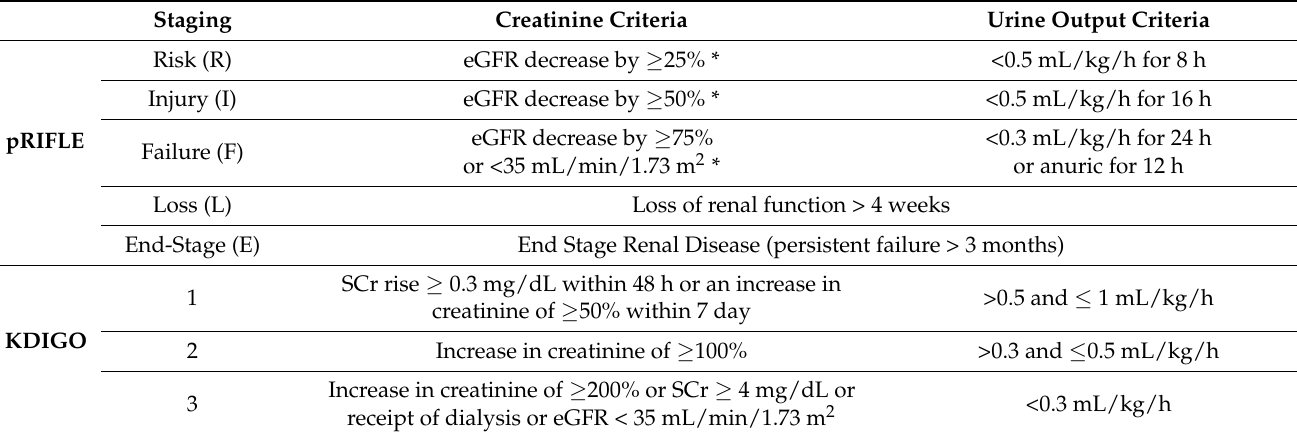
Table 2. Pediatric acute kidney injury definitions, adapted from Sethi et al. (2021)